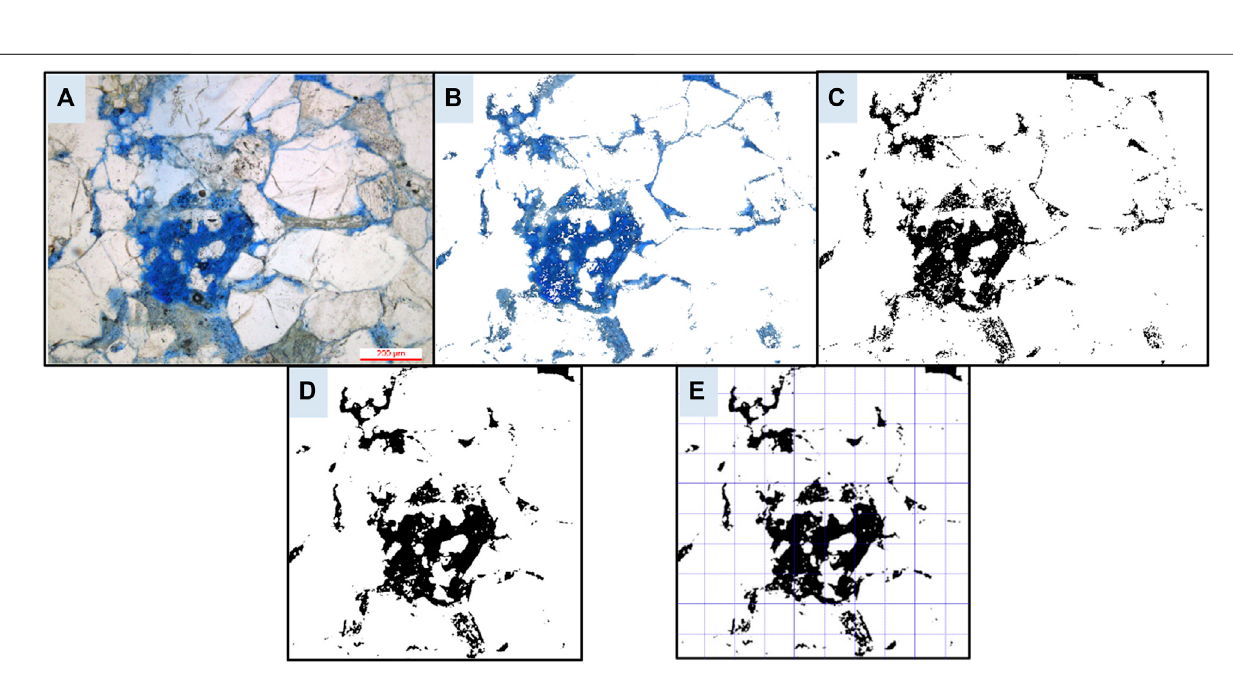
Frontiers in Earth Science |